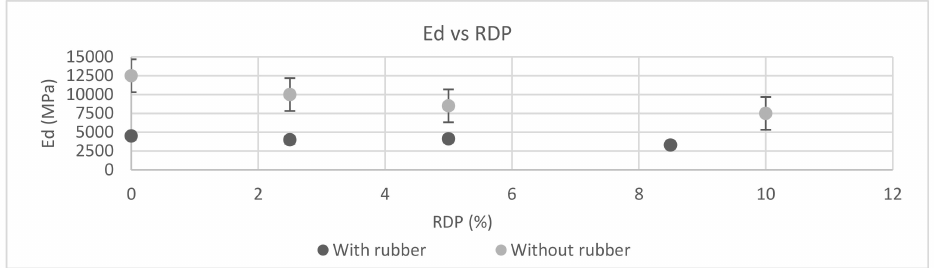
Figure 5. Dynamic elasticity modulus for two tile adhesives with and without recycle rubber incorporation as a function RDP content.